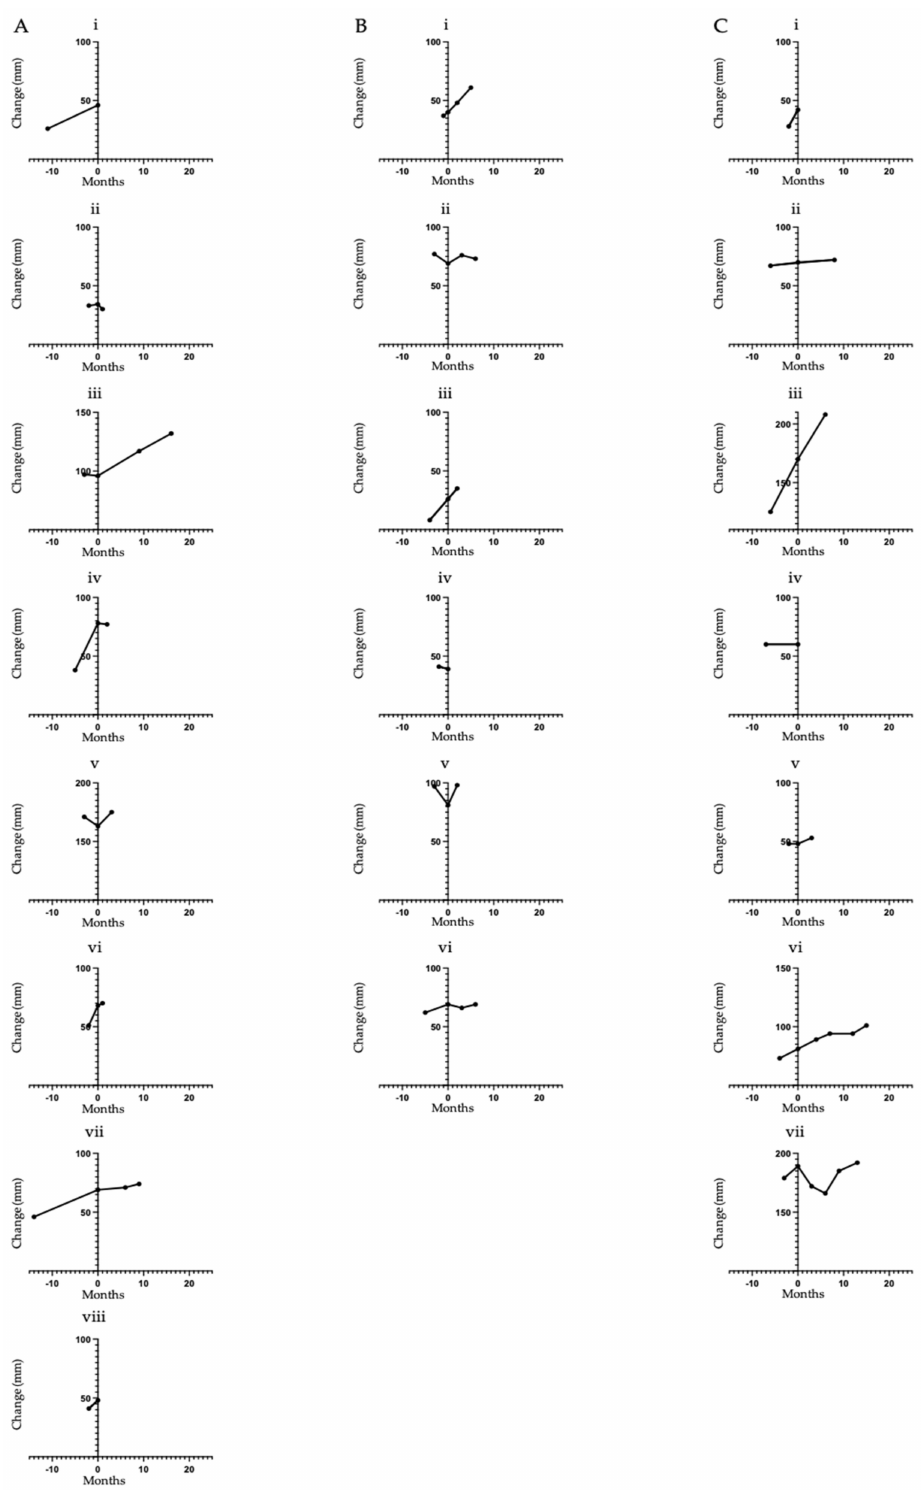
Figure 2. Change in the sum of target lesions over time (mm). ( A ) Patients initiated on lenvatinib 24 mg once daily. ( B ) Patients initiated on lenvatinib 20 mg once daily. ( C ) Patients initiated on lenvatinib 18 mg and 14 mg once daily. The Y axes are standardized using axis breaks to evaluate a 100 mm change in the measurements for comparison of the magnitude of change between patients. Individual patients are labelled